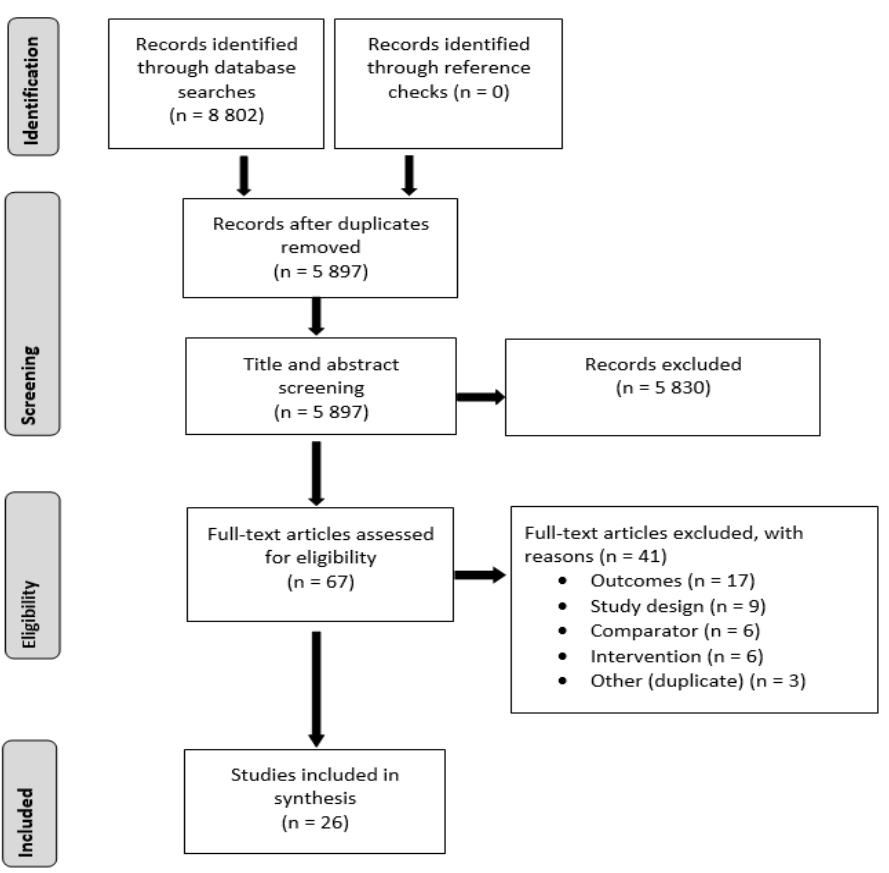
Figure 1. PRISMA flow chart of screening and selection process.